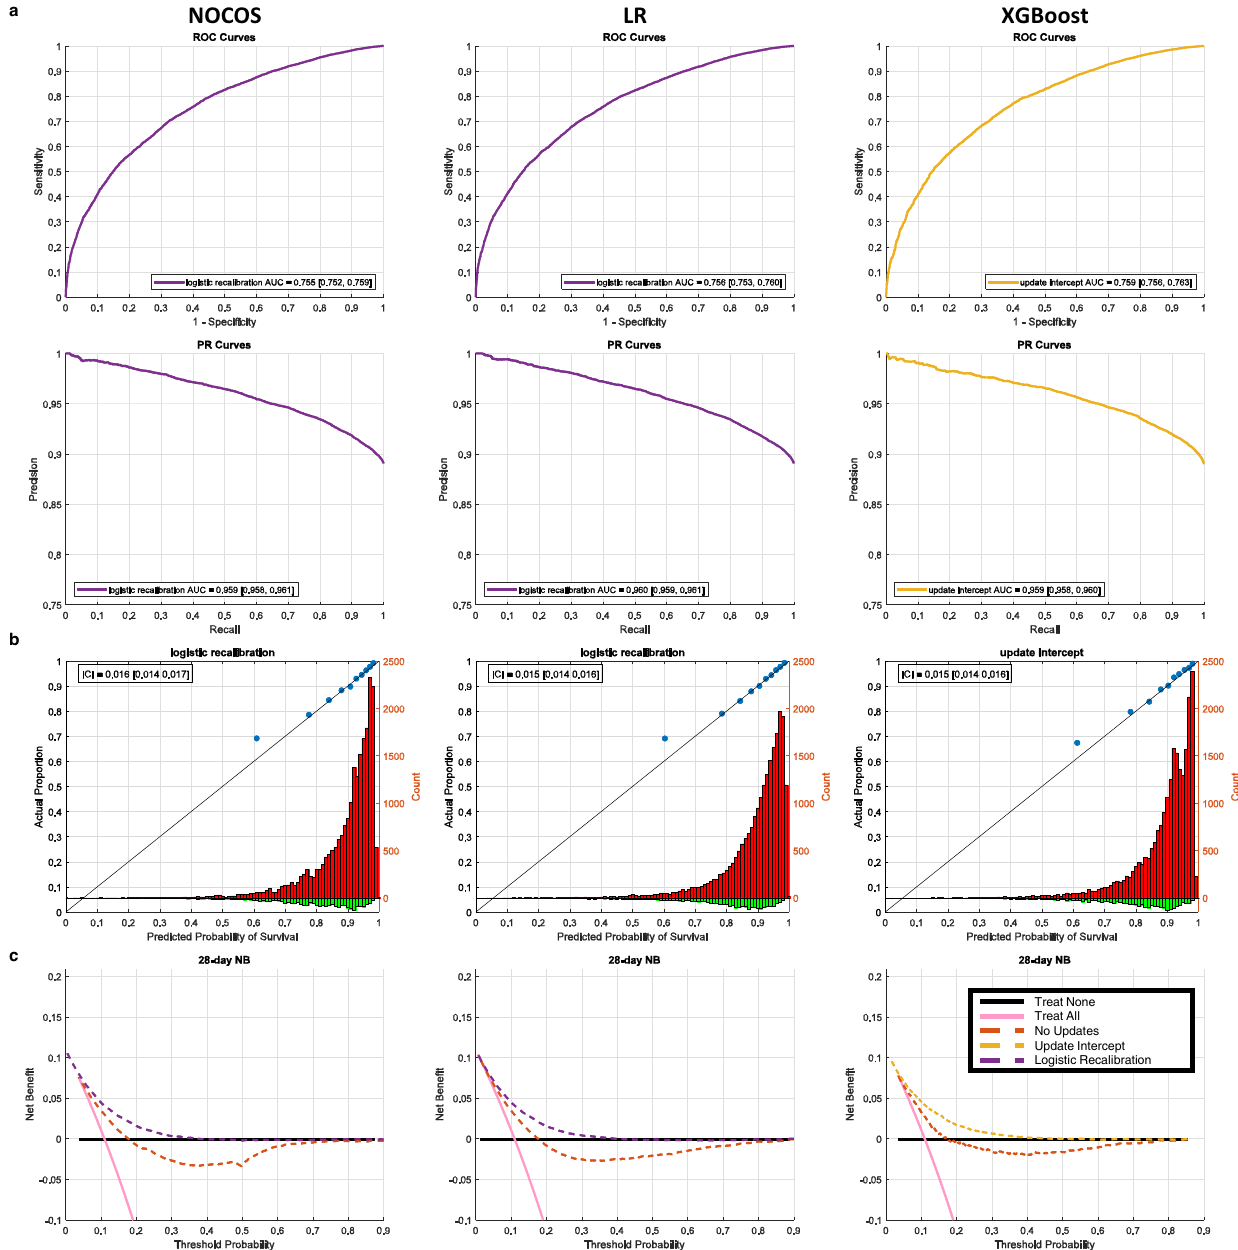
Fig. 4 | Prospective validation of all 28-day self-monitoring, auto-updating models.a ROCandPRcurveswithAUCand95%CIfortheprospective( n =25,677) validation cohort, b calibration plots for the prospective validation cohort, and c decision curves for the prospective cohort based on NOCOS updated using logistic recalibration, logistic regression updated using logistic recalibration, and XGBoost updated using intercept only recalibration. The blue dots on the cali- brationplots show the actualproportionofoutcomesaveraged overdecilesof the